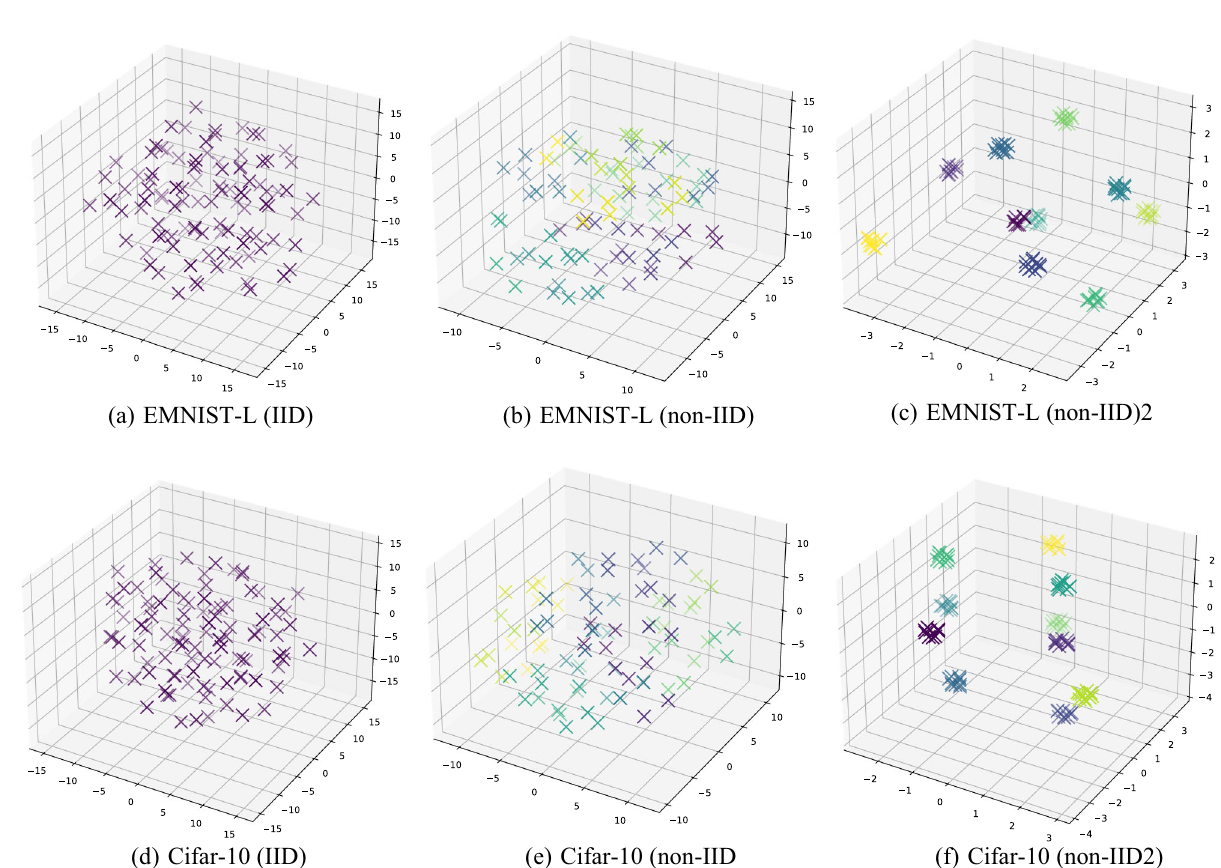
Fig. 9 Clustering results of EMNIST-L and Cifar-10 under the condi- tion of moderate client scale and different data heterogeneity: For the IID split, all clients belong to the same set in the above three